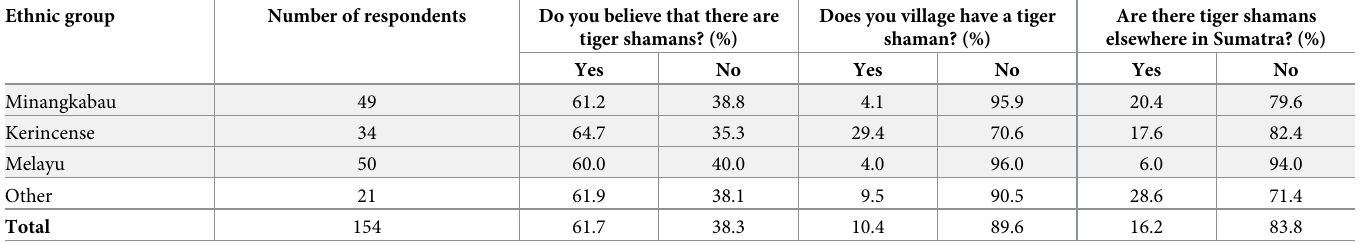
Table 3. The percentage of interviewees from each ethnic group reporting whether they believe in tiger shaman and whether tiger shaman may be found in their vil- lage or elsewhere in Sumatra. Ethnic group Number of respondents Do you believe that there are